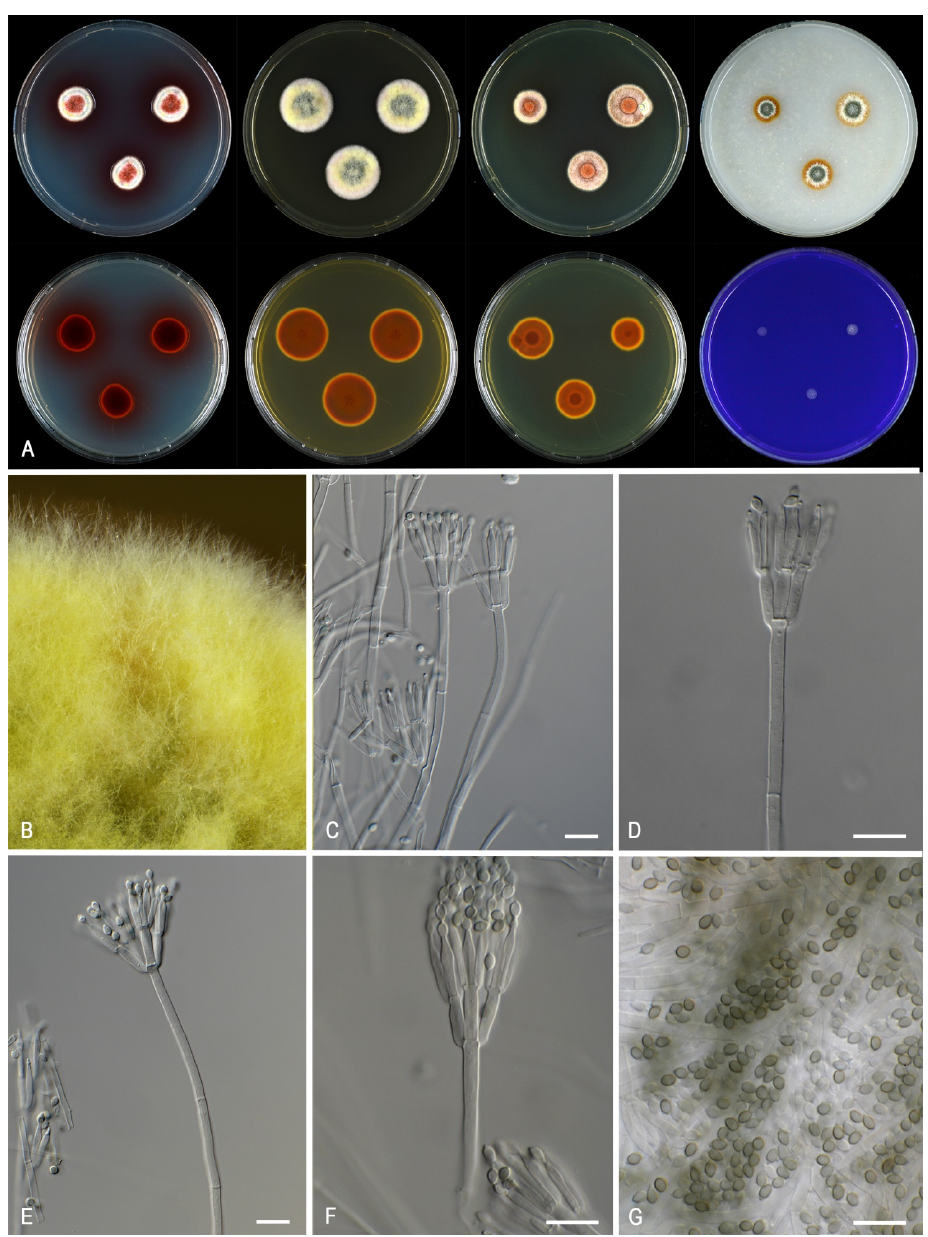
Figure 12. Morphological characters of Talaromyces samsonii (CBS 137.84). ( A ). Colonies, from left to right, after 7 d at 25 °C (top row) CYA, MEA, YES, OA; (bottom row) CYA reverse, MEA reverse, YES reverse, CREA. ( B ). Detail of colony on MEA. ( C – F ). Conidiophores and conidia. ( G ). Conidia. Scale bars = 10 μ m.